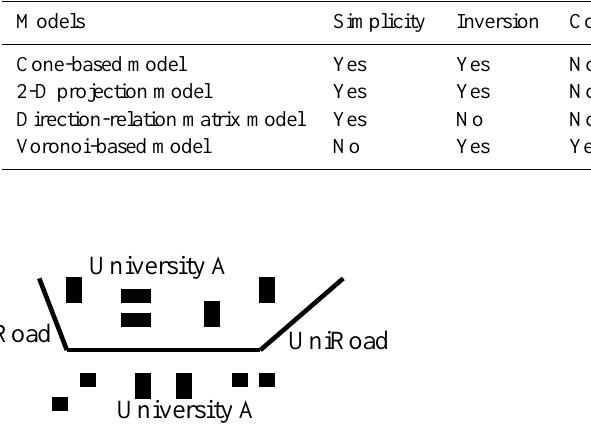
Fig.4 Multi-directions are needed Fig. 4. Multi-directions are needed when two object groups are in- tertwined. Fig.6 If an object group is half-enclosed by another group, when two object groups are Fig. 6. If an object group is half-enclosed by another group, a single direction is not enough to describe their direction a single direction is not enough to describe their direction intertwined. relations. P